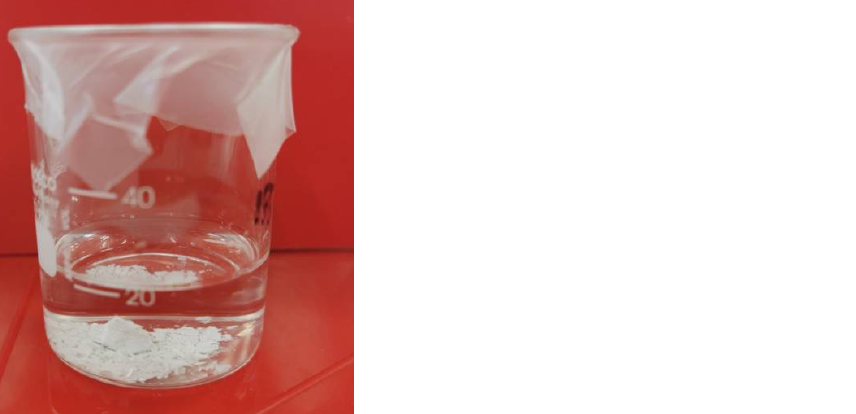
Figure 3. pH of HBSS over 2 weeks following the addition of the experimental pulp-capping agent.